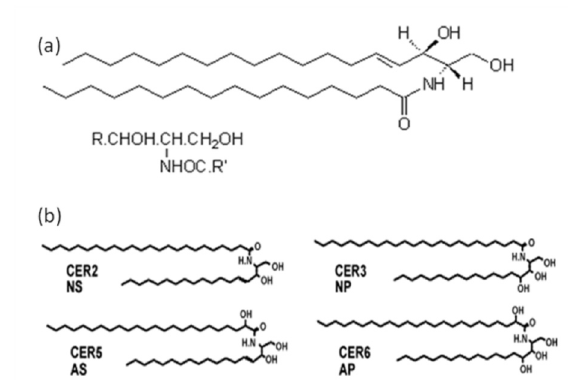
FIGURE 1 - (a) General structure of the ceramides. (b) Representative molecular structure of SC ceramides according to WERTZ (1992). NS : long-chain non-hydroxy fatty acid sphingosine, AS : α-hydroxy fatty acid sphingosine, NP : long-chain non-hydroxy fatty acid phytosphingosine and AP : α-hydroxy fatty acid